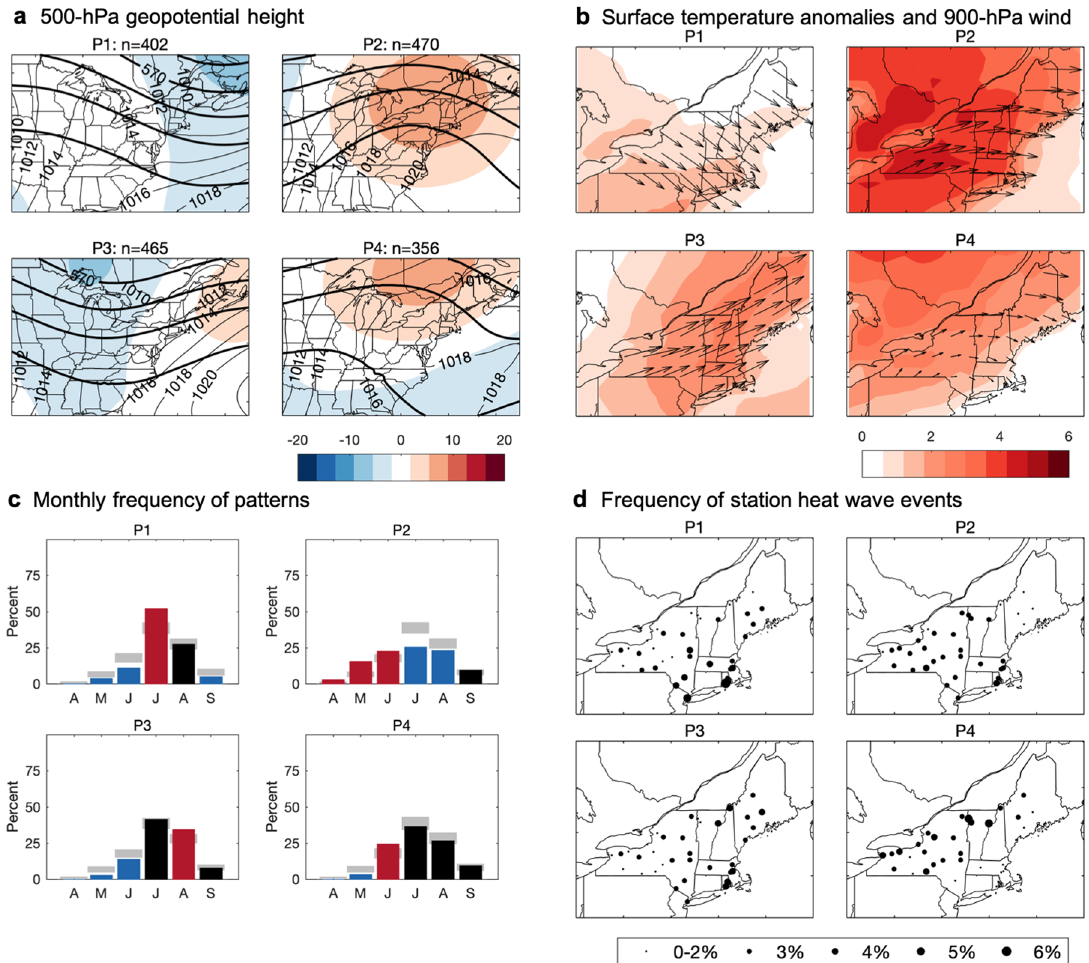
Fig. 1 Regional heat wave day patterns. Composites for P1 – P4 days of a 500-hPa geopotential heights (thick contours every 6 dam, anomalies shaded every 4 dam) and MSLP (thin contours every 2 hPa), and b 2-m temperature anomalies (shaded, in 0.6 K increments) and 900-hPa winds (quivers, largest quiver 8.5 ms − 1 ). c April – September frequency of P1 – P4 days with gray shading indicating the 95% con fi dence interval using random sampling of all regional heat wave days ( n = 1693), and red, blue, and black bars indicating, respectively, higher-than- normal, lower-than-normal, and normal monthly values at the 0.05 level of signi fi cance. d Relative frequency (percent) of station heat wave days assigned to P1 – P4 (for each station, number of heat wave days in speci fi c pattern divided by total number of all-station heat wave days for speci fi c pattern, represented by black dots, where size of dot is proportional to frequency). Heat wave patterns are from k-means clustering of MERRA-2 1980 – 2018 500-hPa geopotential height and 900-hPa wind daily anomalies (based on the climatological daily